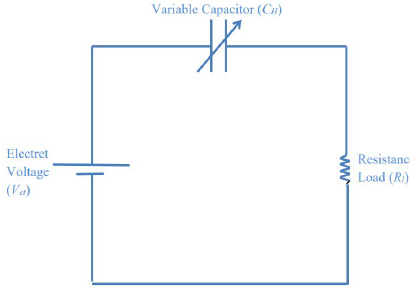
Figure 1. A schematic diagram for the electret-based microcantilever energy harvester.